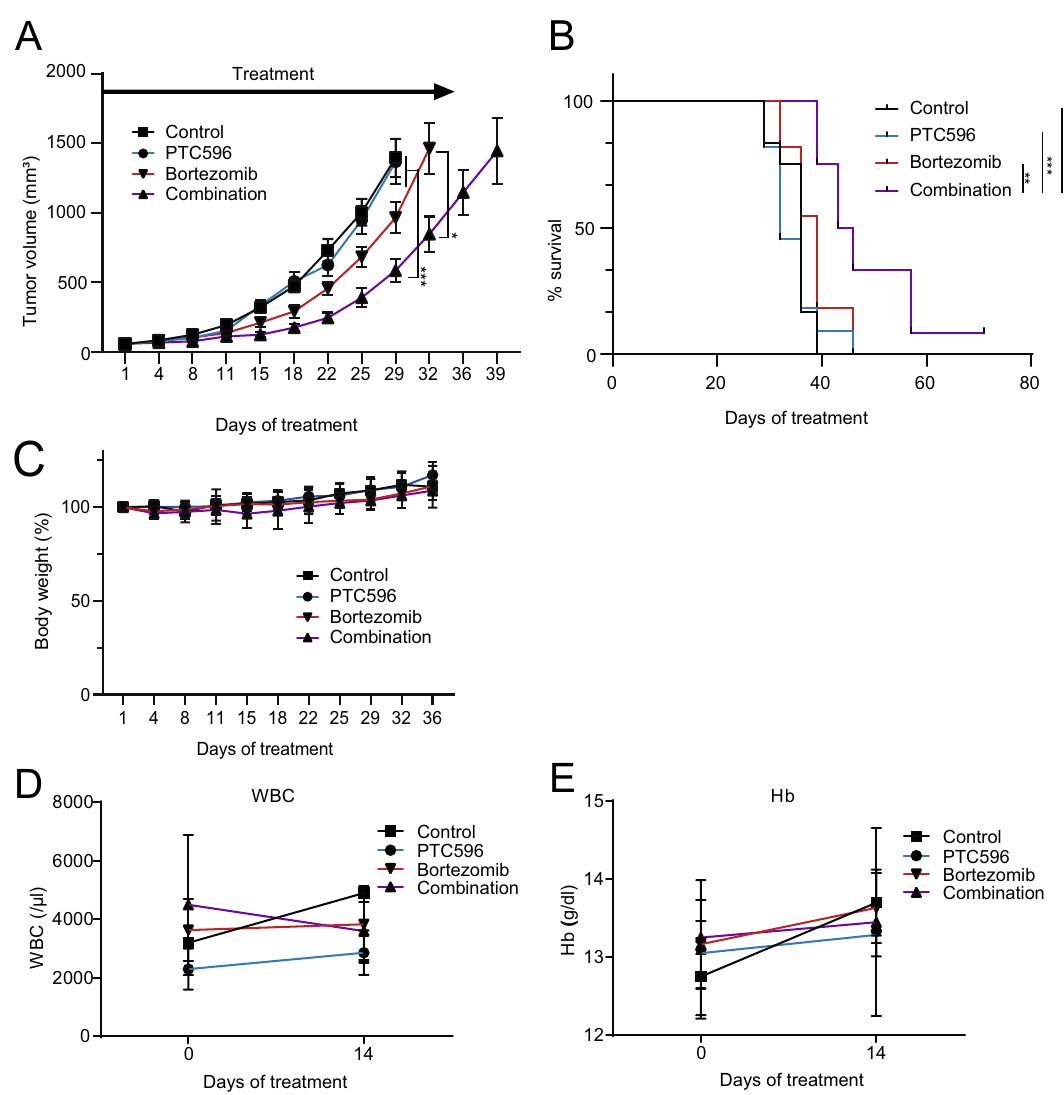
Figure 4. PTC596 and bortezomib exert synergistic anti-MM activity in a xenograft MM model. NOG mice were injected subcutaneously on the right side of the back with 4 × 10 6 MM.1S cells. After the tumor grew to a measurable size, treatment was initiated. Mice were treated for 5 weeks with oral PTC596 (6.25 mg/kg) twice a week, subcutaneous bortezomib (0.5 mg/kg) in the left side of the back twice a week, or the combination. Control mice received orally administered vehicle and subcutaneous saline for 5 weeks. ( A ) Tumor volume was monitored twice a week in PTC596-treated group (n = 11), bortezomib-treated group (n = 11), combination group (n = 12), and vehicle-treated group (n = 12). Data represent mean ± SEM. * P < 0.05; *** P < 0.001 using one-way ANOVA and Student’s t -test. ( B ) Kaplan–Meier survival of mice. The mice were sacrificed when the tumors reached 2,000 cm 3 or an ulcer occurred. Survival was evaluated from the first day of treatment to death. Statistical significance was determined using the log-rank test. ** P < 0.01; *** P < 0.001. ( C ) Body weight of the mice. Data represent mean ± SD. ( D ) White blood cell counts and ( E ) Hemoglobin (Hb) of the mice examined on the indicated day of treatment. Data represent mean ± agents largely overlapped. Of interest, endoplasmic reticulum (ER)-related gene ontology terms were signifi- cantly enriched in 5299 overlapping genes (Fig. 6A, Supplementary Table S7). RT-PCR analyses revealed the upregulation of representative ER stress-related genes, such as DDIT3 (also known as CHOP or GADD153), HSPA5 (also known as BiP or GRP78), and ATF4 , by bortezomib treatment and to a lesser extent by PTC596 treatment. Of note, the expression of ER stress-related genes induced by bortezomib 27 was significantly enhanced by the combination treatment (Fig. 6B). Among ER stress-related genes, DDIT3 encodes a transcriptional factor CHOP which is related to fatal ER stress 27 . We confirmed that the protein levels of CHOP and BiP were elevated by the combination treatment by western blotting (Fig. 6C). Importantly, knockdown of ATF4 and DDIT3 by shRNA lead to the suppression of the cytotoxicity of the combination treatment, indicating that the ER stress pathway at least partially contributes to the synergy of PTC596 with bortezomib (Supplementary Fig. S4).